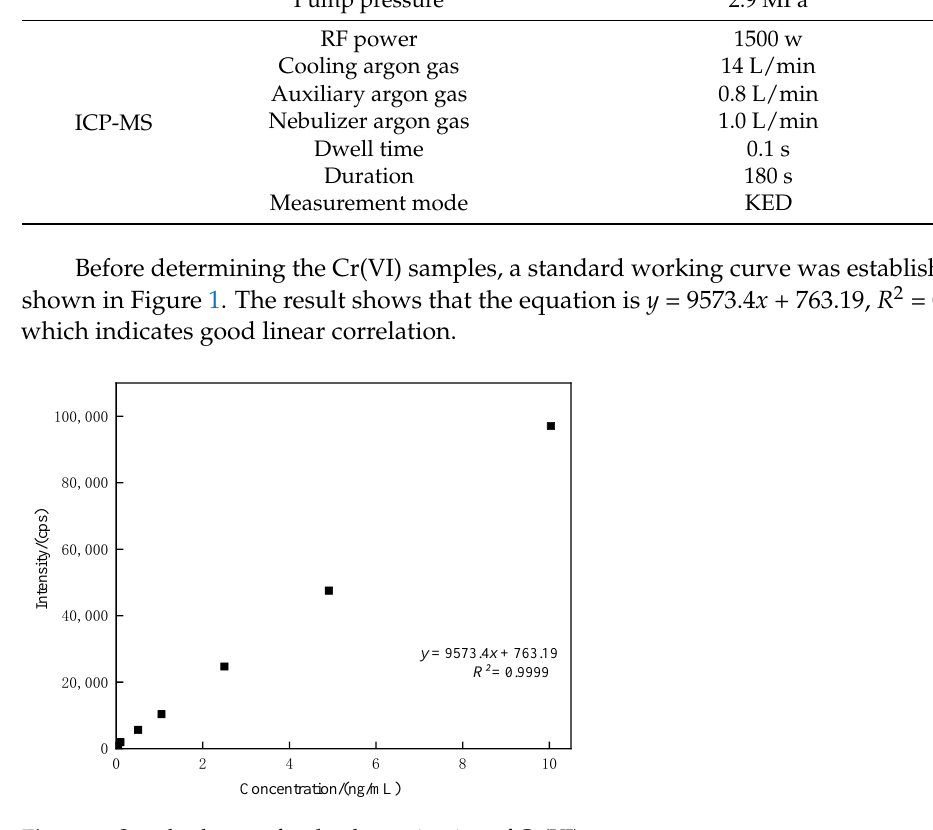
Figure 1. Standard curve for the determination of Cr(VI).